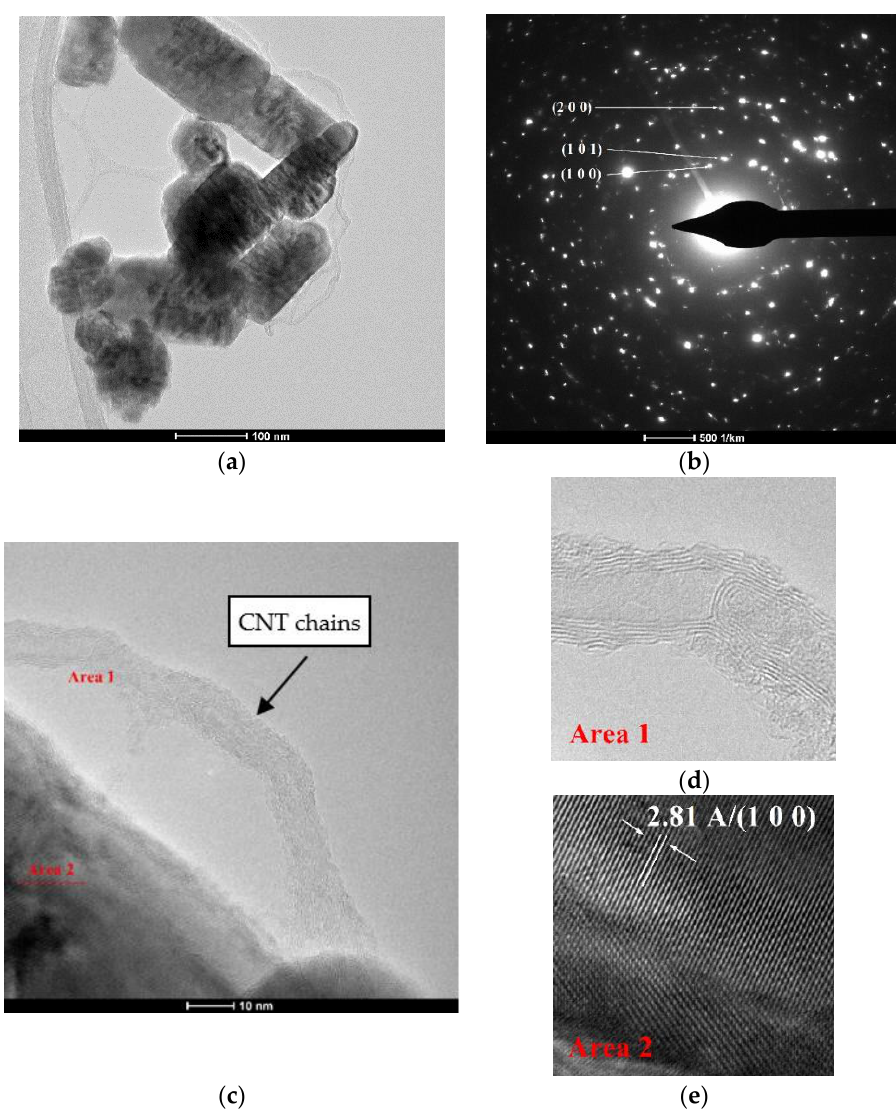
Figure 8. TEM images of CNT-ZnO-2 (weight ratio CNT:ZnO = 1:10) — nanocomposite sample: ( a ) polyhedreral rod-like shaped ZnO nanoparticles covered with CNT (scale 100 nm); ( b ) SAED obtained on ZnO nanoparticles covered on the surface with CNT; ( c ) HR-TEM image of nanocomposite powder at 10 nm; ( d ) detail of MWCNT presented in ( c , e ) detail of crystalline ZnO presented in ( c ).